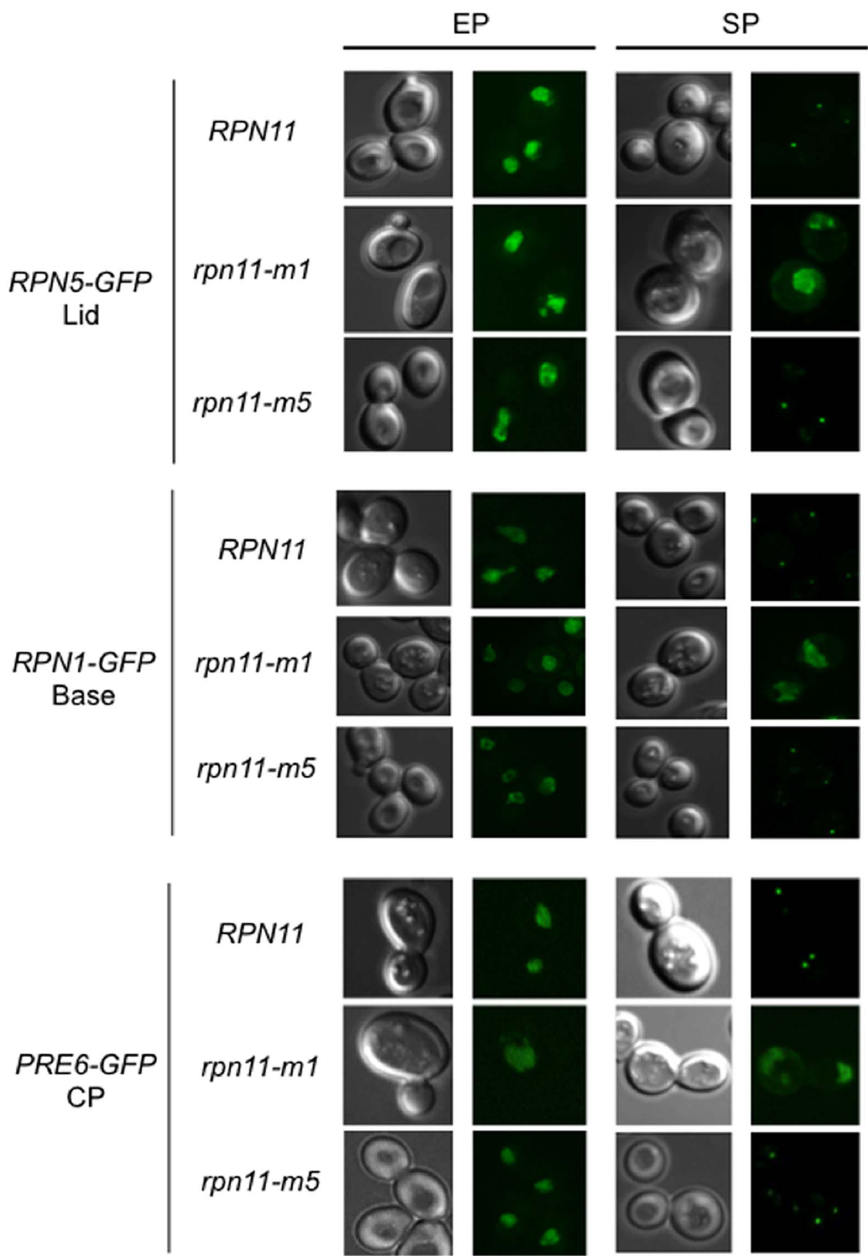
Figure 2. Proteasome subunits localization in exponential and stationary growth phases. Wild type, rpn11-m1 and rpn11-m5 cells expressing Rpn5-GFP (W303), Rpn1-GFP (W303) or Pre6-GFP (BY4741) were grown in glucose and adenine containing rich medium (YPDA) at 26 u C and examined by fluorescence microscopy in the exponential growth phase (EP) and after 5 days in stationary phase (SP). Typical images of each subunit fused to GFP localization are shown. (CP/20S Core